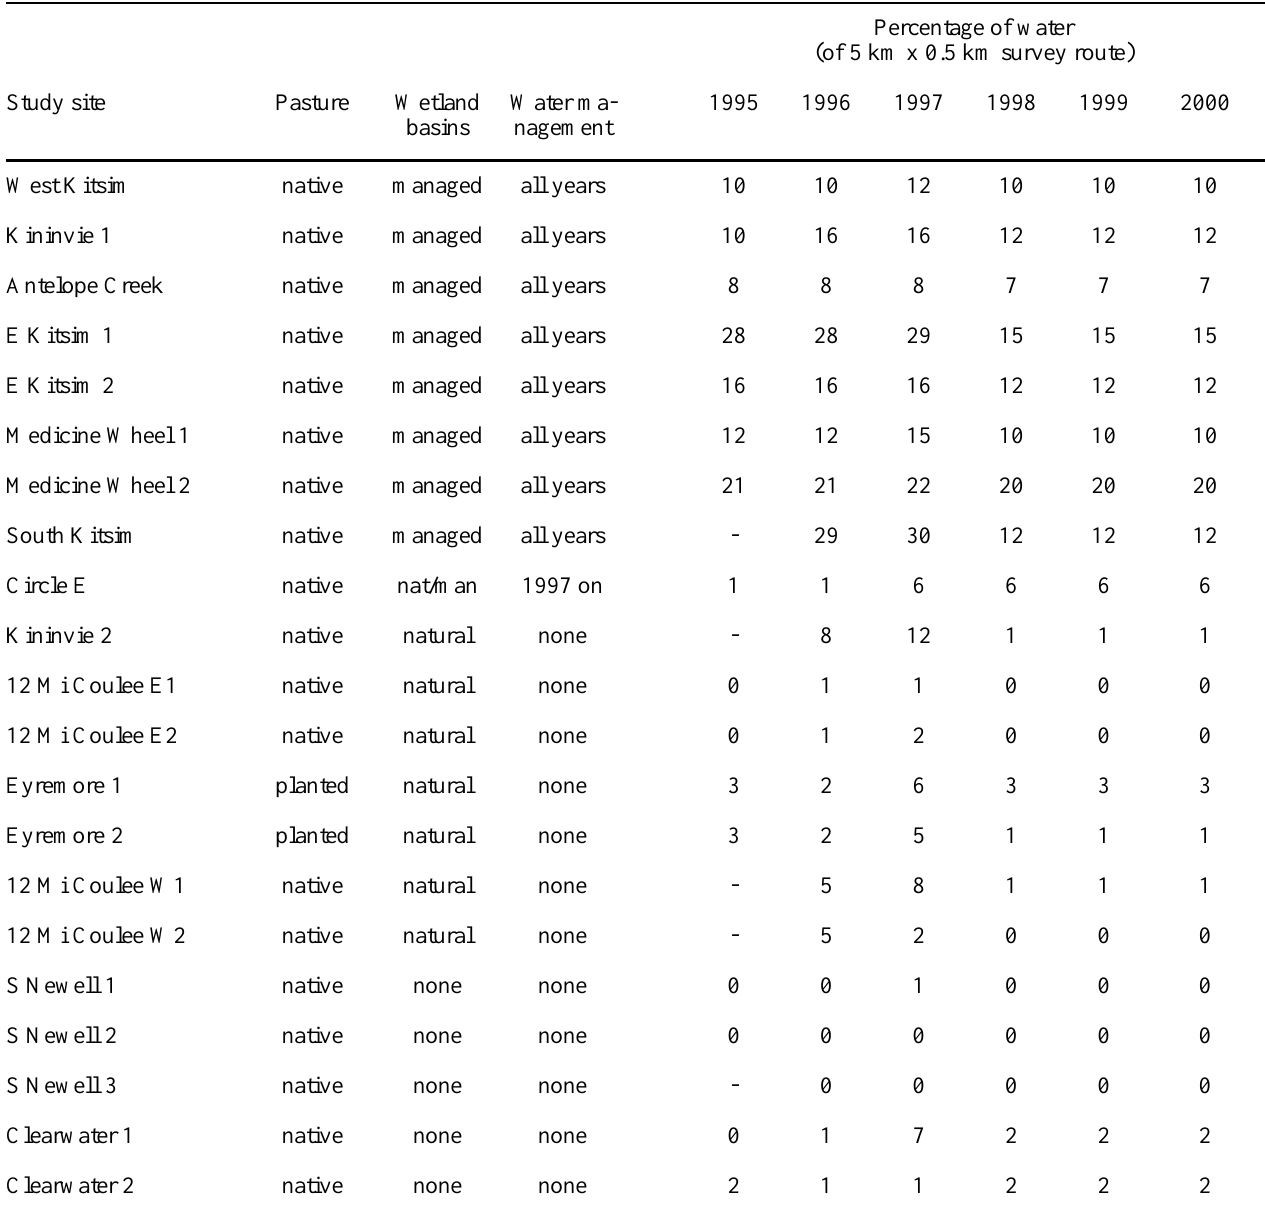
Table 1. Descriptive summary of survey sites from 1995 to 2000 in southern Alberta, including the percentage of the survey route area covered in water during the first survey each